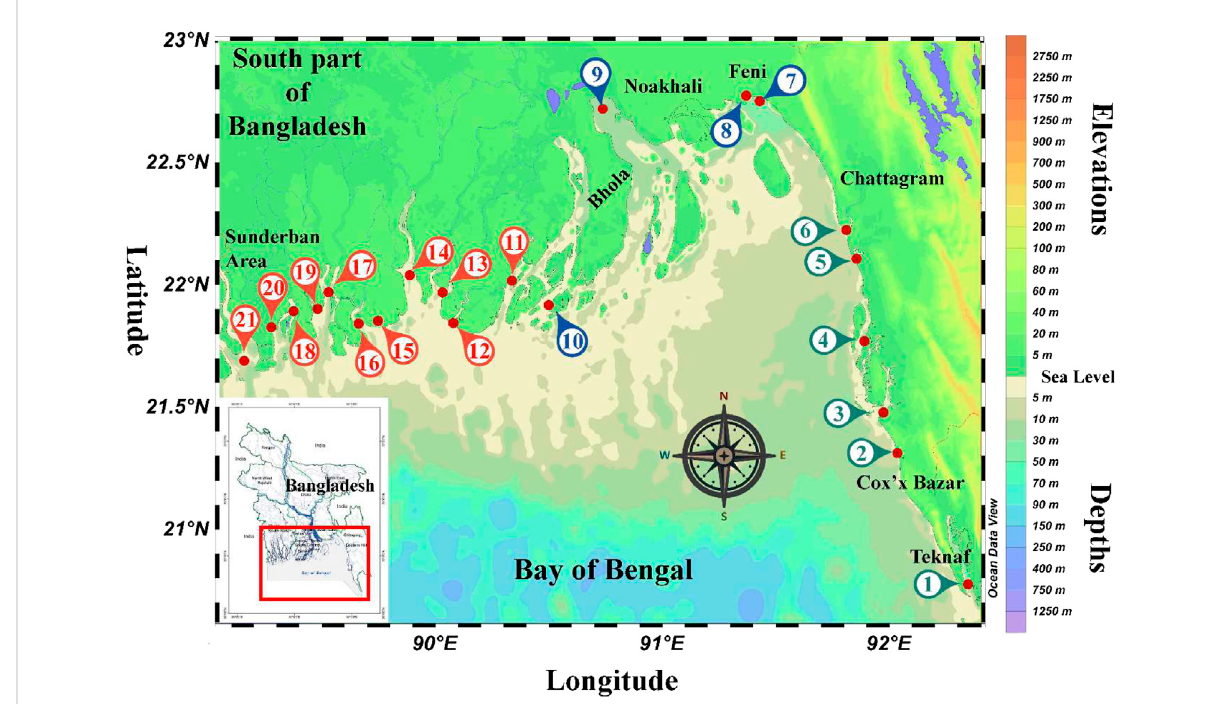
FIGURE 1 Location of each investigated estuaries in this review, where, 1: Naf River Estuary; 2: Rezu Cannal Estuary; 3: Bakkhali River Estuary; 4: Matamuhuri River Estuary; 5: Sangu River Estuary; 6: Karnaphuly River Estuary; 7: Feni River Estuary; 8: Choto Feni River Estuary; 9: Meghna River Estuary; 10: Tetulia River Estuary; 11: Galacipa River Estuary; 12: Andharmanik River Estuary; 13: Payra River Estuary; 14: Balaswar River Estuary; 15: Betmore River Estuary; 16: Sela River Estuary; 17: Pussur River Estuary; 18: Arpangachia River Estuary; 19: Sundarban River Estuary; 20:Malanchi River Estuary; 21: Ichamoti River